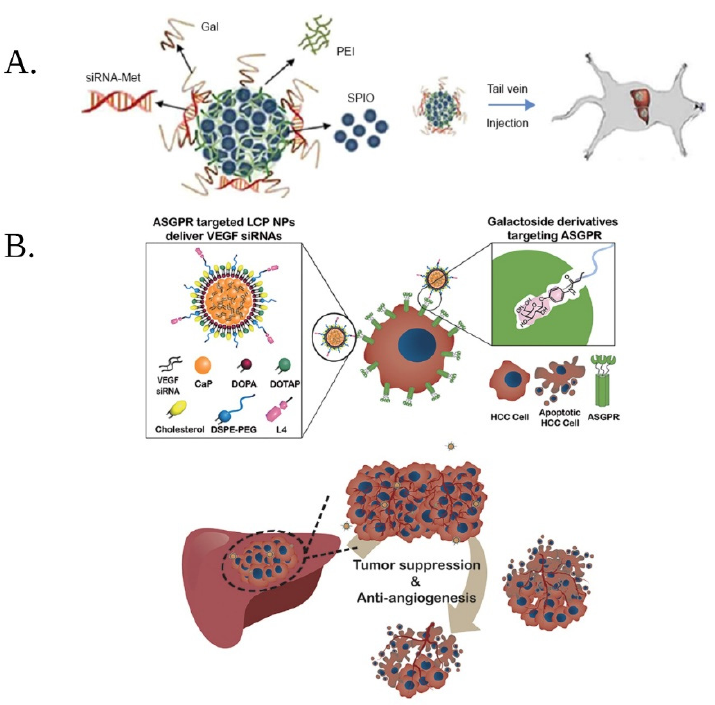
Figure 3. ( A ) Schematic representation of the development strategy for superparamagnetic iron oxide nanoparticles (SPIONs) modified with polyethylenimine (PEI), galactose (Gal), and siRNA as well as their administration in rats, for the treatment of HCC; (adapted from reference [78] (Open Access)); ( B ) Schematic representation of the development strategy of galactose-modified lipid/calcium/phosphate nanoparticles (LCP NPs) incorporating anti VEGF siRNA; DOPA— 1,2-dioleoyl-sn-glycero-3-phosphate; DOTAP—1,2-dioleoyl-3-trimethylammonium-propane; DSPE- PEG—1,2-distearoyl-sn-glycero-3-phosphoethanolamine-N-[amino (polyethylene glycol)-2000]; L4— phenyl β -D-galactoside (adapted with permission from reference [75]). (Copyright 2022 American Chemical Society. Created with